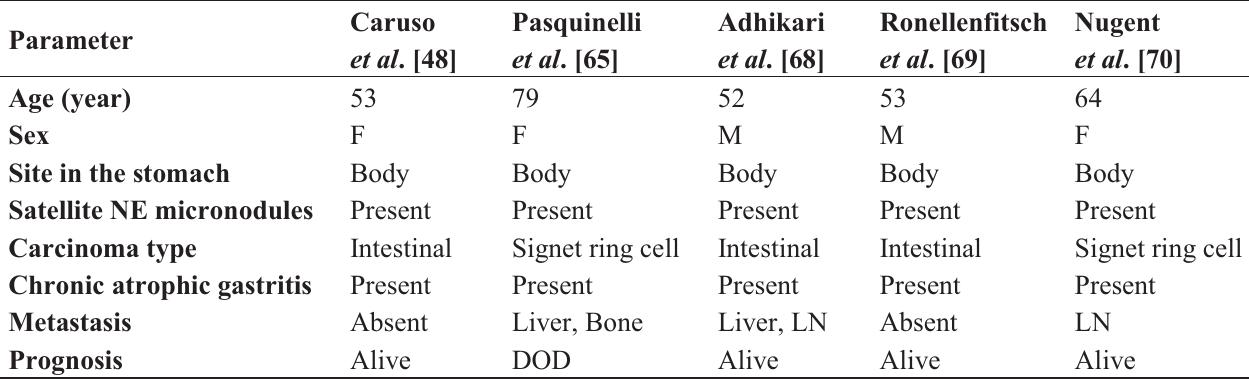
Table 2. Clinico-pathologic features of adenocarcinoma-neuroendocrine tumor (NET) in autoimmune chronic atrophic gastritis.